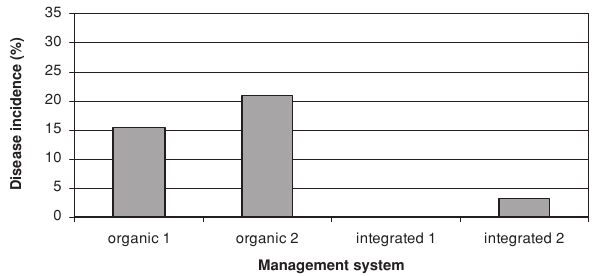
Figure 1: Efficacy of standard and reduced spray programmes on cherry leaf spot on leaf in integrated and organic sour cherry orchards in 2008 (LSD = 4.8 – integrated; LSD = 7.6 – organic). 0.05